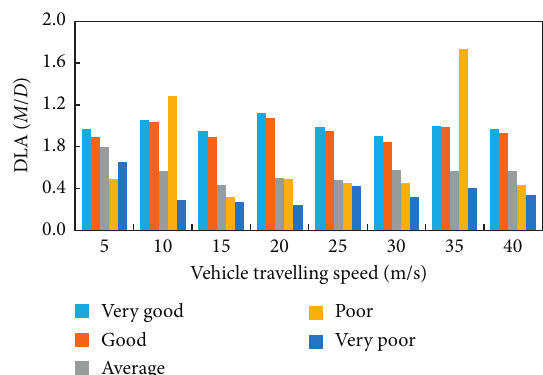
Figure 13: DLAs for the different responses of the main girder.